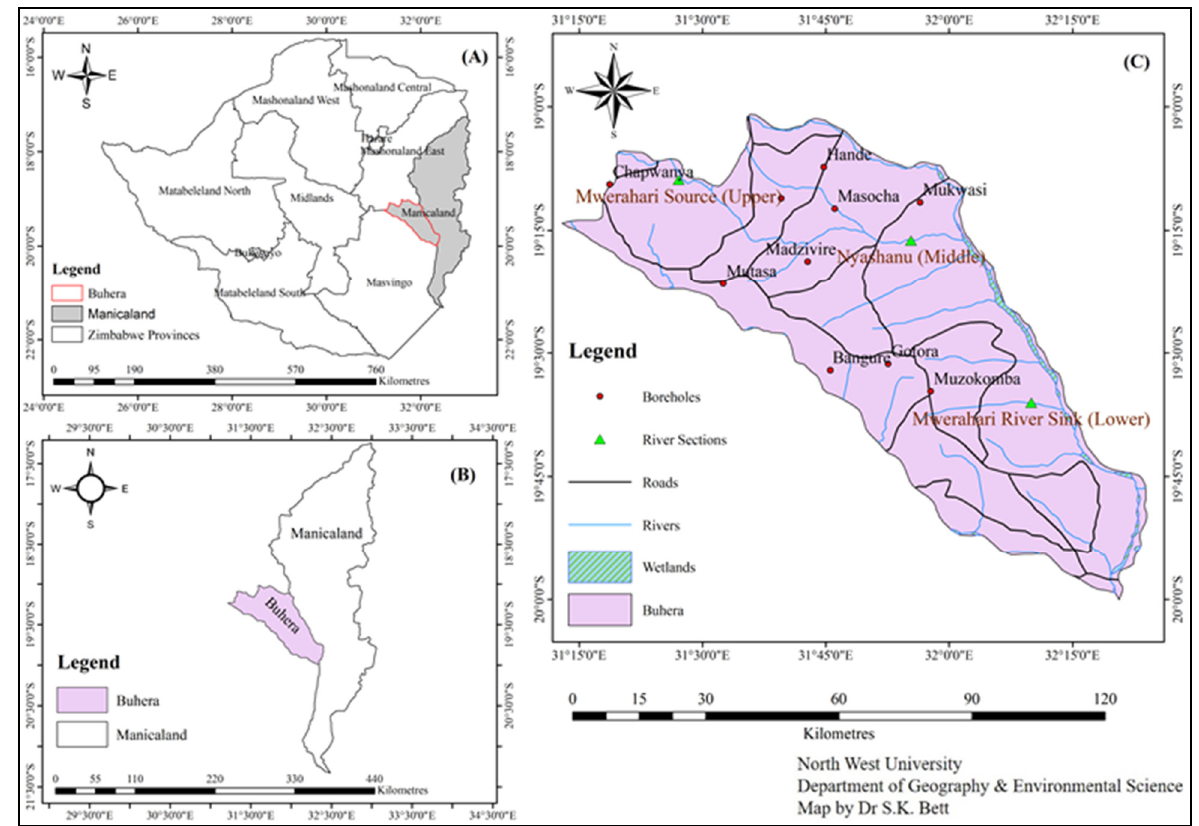
Figure 1. Map of the study area .